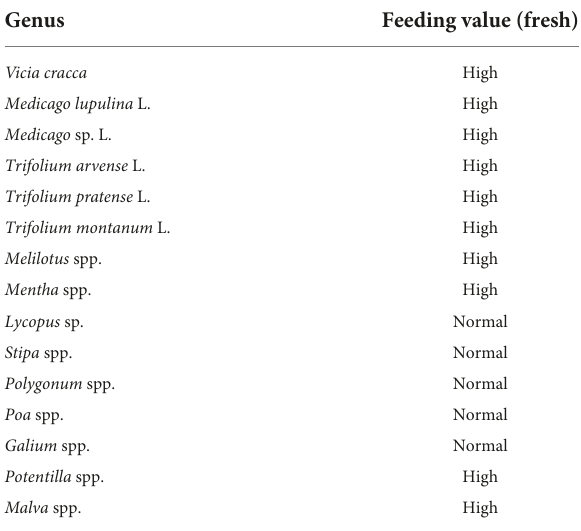
TABLE 3 potential forage plants in meadow zones are represented in the archaeobotanical samples with the indication of value. Genus Feeding value